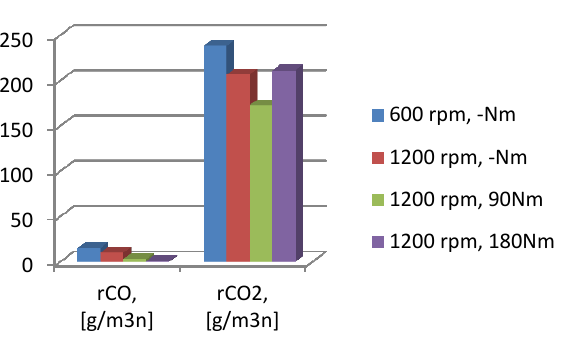
Fig. 15. Amount of CO and CO 2 concentration in exhaust gases The high NO value in Fig. 14. is caused by the fact that x the engine used only an oxidation catalyst.